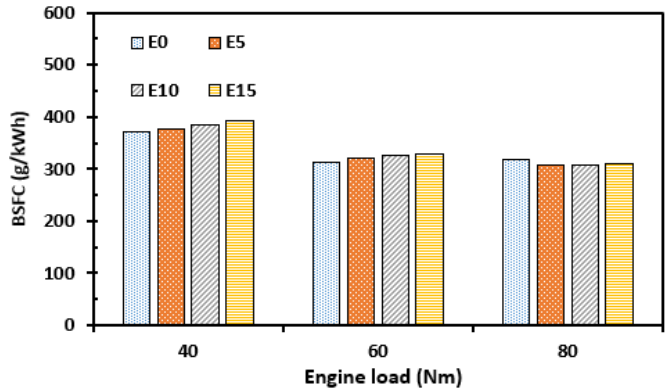
Figure 2. Brake-specific fuel consumption.